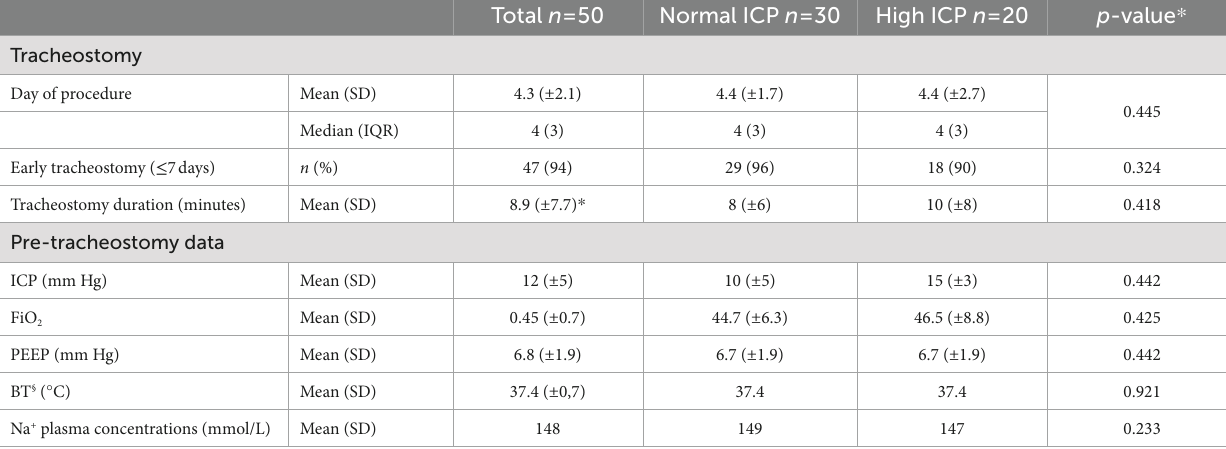
TABLE 2 Baseline tracheostomy and pre-tracheostomy data in the overall population and stratified according to normal versus high ICP status.